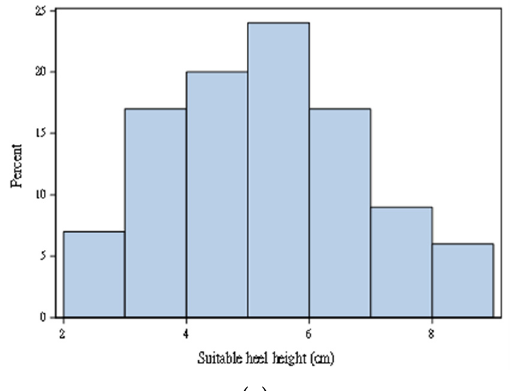
Figure 3. ( a ) Maximal observed safe heel height for ( a ) right foot; ( b ) left foot.